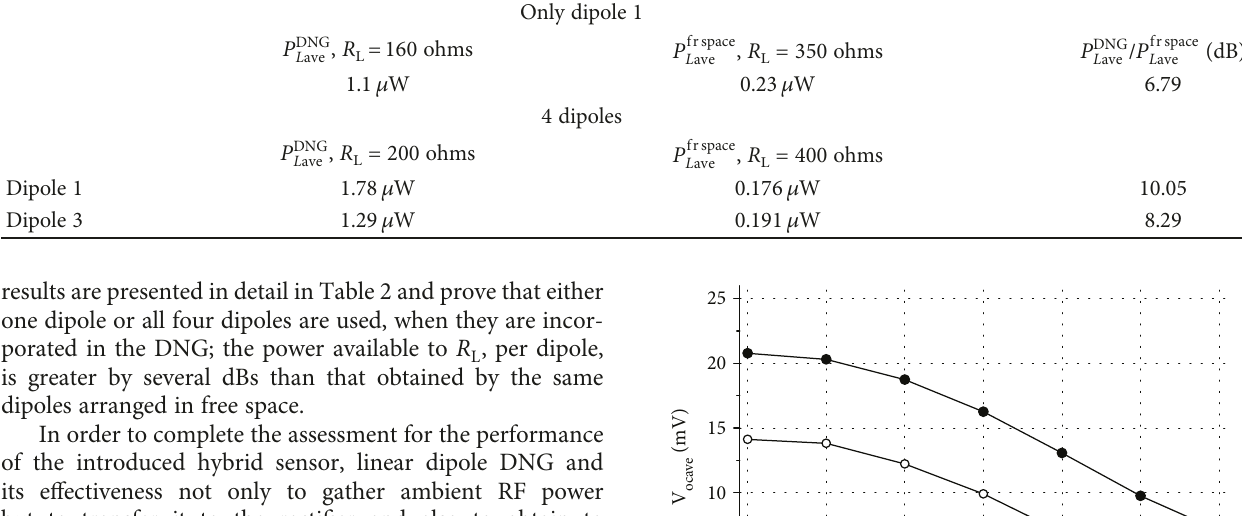
Table 2: Average power available per dipole on the load R